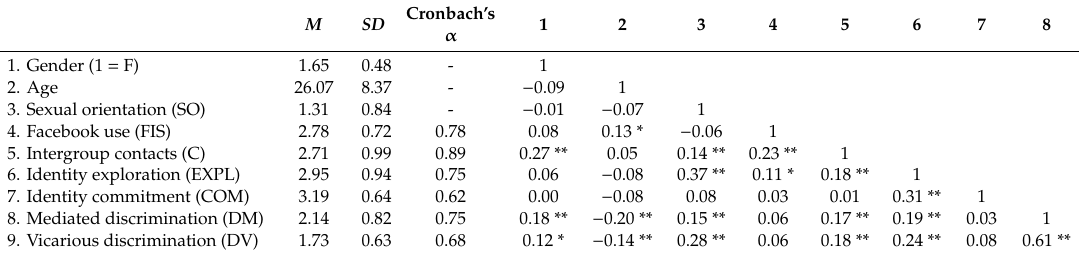
Table 1. Mean and standard deviation and zero-order correlations of considered measures (n = 357). Cronbach’s M SD α 1 2 3 4 5 6 7 8 1. Gender (1 = F) 1.65